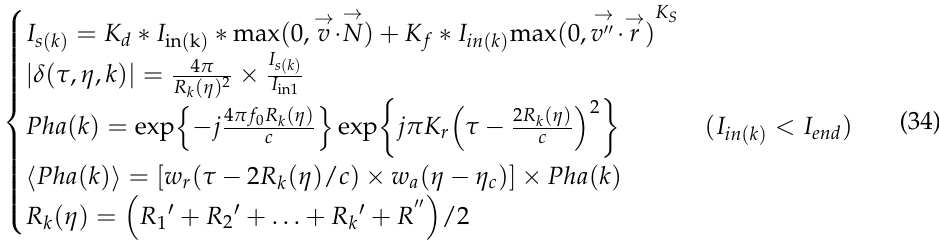
Figure 8. The k - th backscatter magnitude matrix of point target: ( a ) magnitude matrix before the envelope; ( b ) magnitude matrix after the envelope. Each point target corresponds to n discrete electromagnetic waves transmitted by the platform, which are limited by the azimuth envelope. As shown in Figure 8b, the actual number of effective pulses is equal to the number of transmitted pulses within the synthetic aperture time. Therefore, the two-dimensional k -th backscatter field contains less than n kinds of magnitude. Finally, we perform vector superposition of the multi- ple backscatter fields to obtain the echo signal of the point target. 3.4. Generation and Imaging of the Echo Signal The echo signal of each point target is the basic unit of the whole target echo signal. The operation of vector superposition is performed on the echo signal of all lattice targets to obtain the echo signal of the whole target including multiple scattering. The raw echo signal can be expressed as: